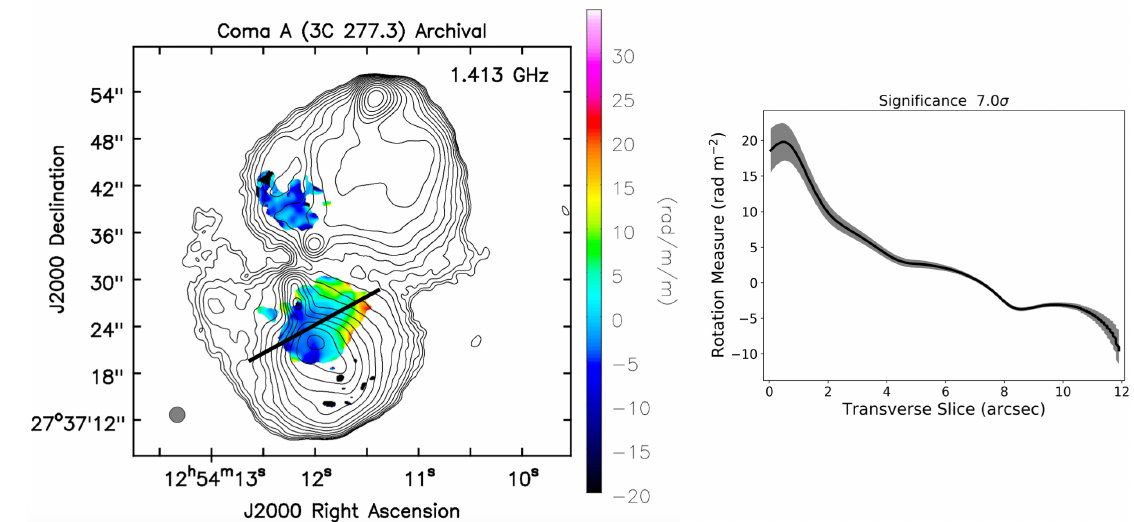
Figure 2. Left panel shows a Faraday rotation measure image made using archival VLA observations at 1.4 GHz, 4.9 GHz and 15 GHz. The VLA configurations used ensured the uv coverage was matched. The total intensity contours start at 0.6 mJy and increase by factors of circle in the lower left corner of the image. Right panel shows the slice taken along the RM along the path taken by the black line in the right panel. The gray shading is the 1 σ error in the RM for each